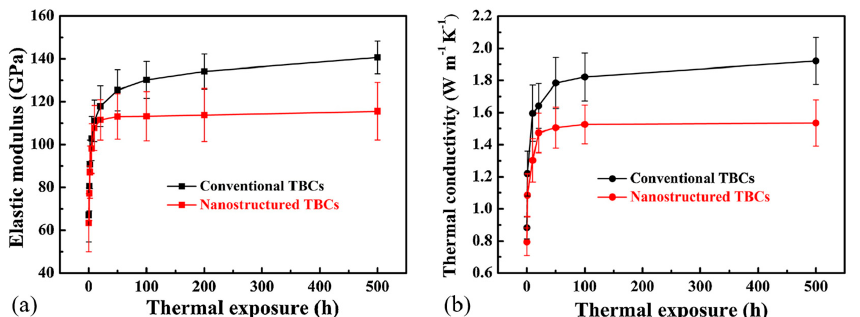
Figure 44. Global structural evolution during thermal exposure: ( A ) conventional TBCs ( B ) nanostructured TBCs [233] .